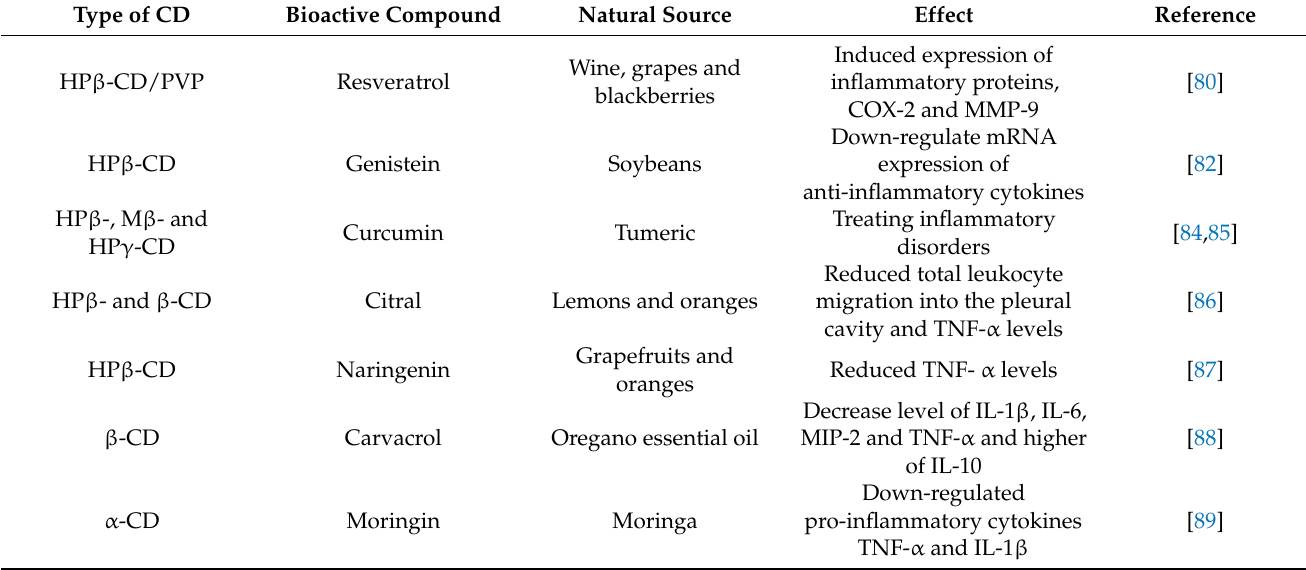
Table 3. Summary of the most relevant bioactive compounds and their